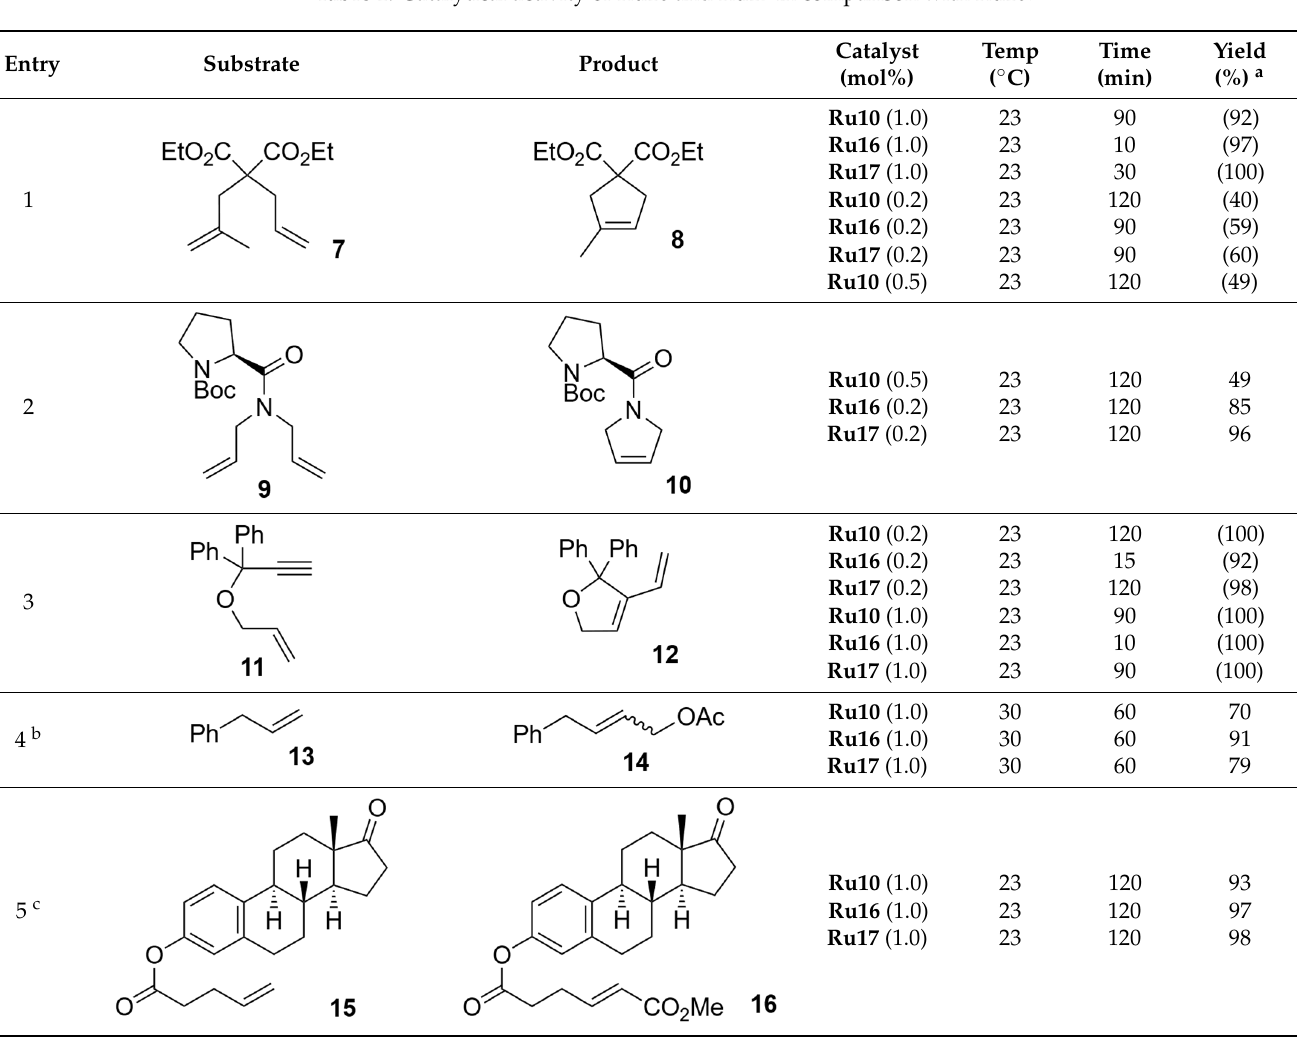
. Table 1. Catalytical activity of Ru16 and Ru17 in comparison with Ru10 .